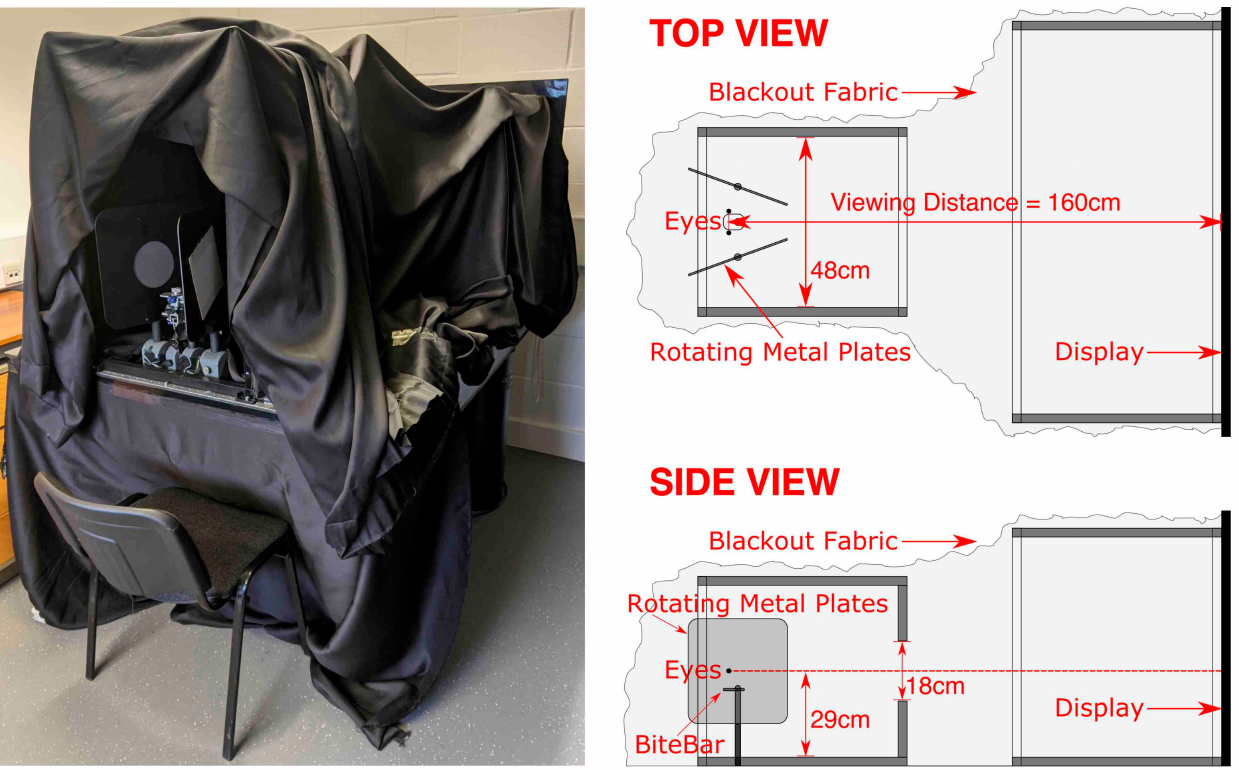
Figure 4. Photograph and cross-section plans of the